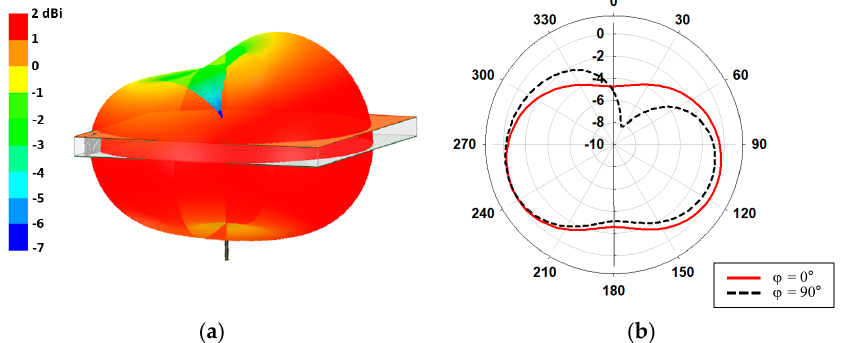
Figure 7. Effect of shorting pins on the 2D antenna radiation pattern.